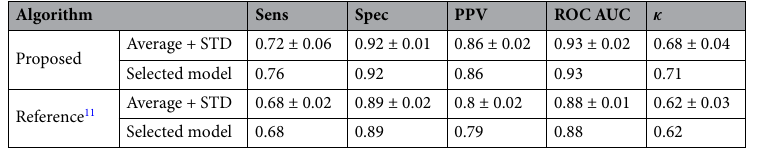
Table 4. Results of the proposed and reference approach on test1 of UZL including only signals with agreed labels between annotators. The first row of each block shows the average and standard deviation of each metric for all the iterations performed (10 training-test combinations for each of the 3 kernels). The second one shows the results of the selected models, corresponding to the best training-test combination for the linear kernel.